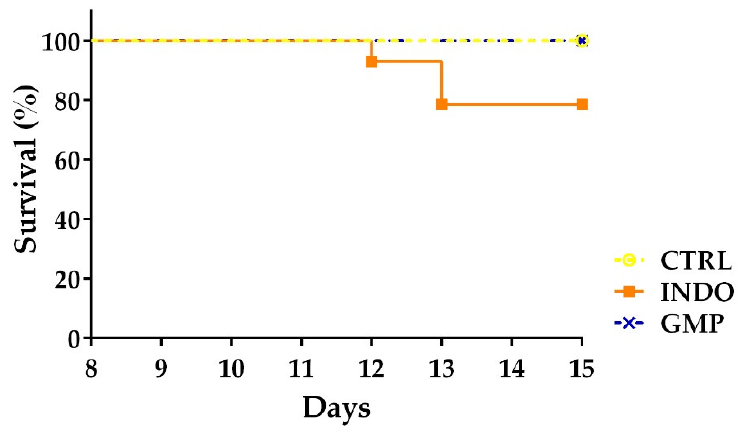
Figure 7. Effect of treatment with glycomacropeptide (GMP) on the survival of rats with indomethacin-induced enteropathy. Data as presented as percentage (%) of animal survival each day of the damage-induction protocol in the CTRL, INDO and GMP groups ( n = 14 at day 8).